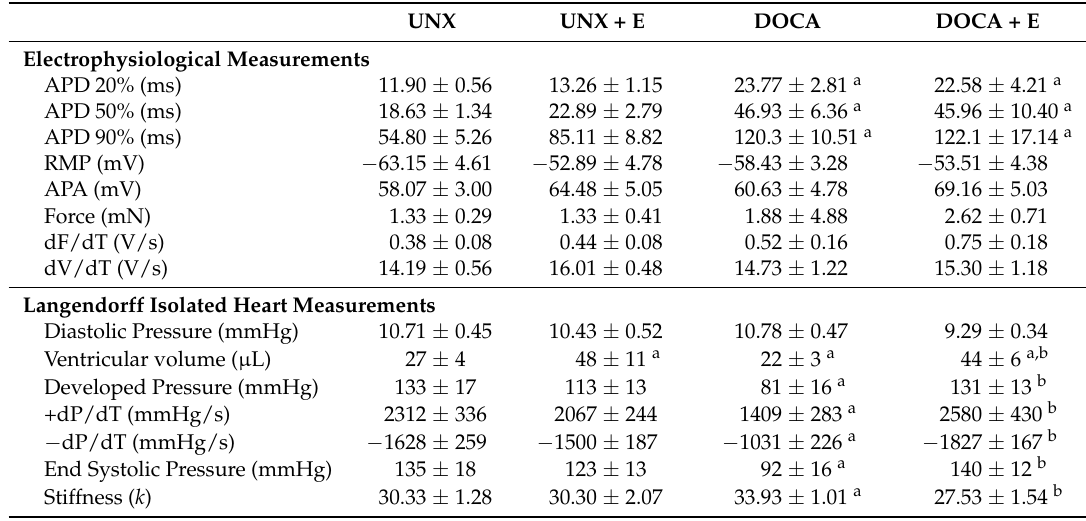
Table 4. Electrophysiological and isolated-heart analysis